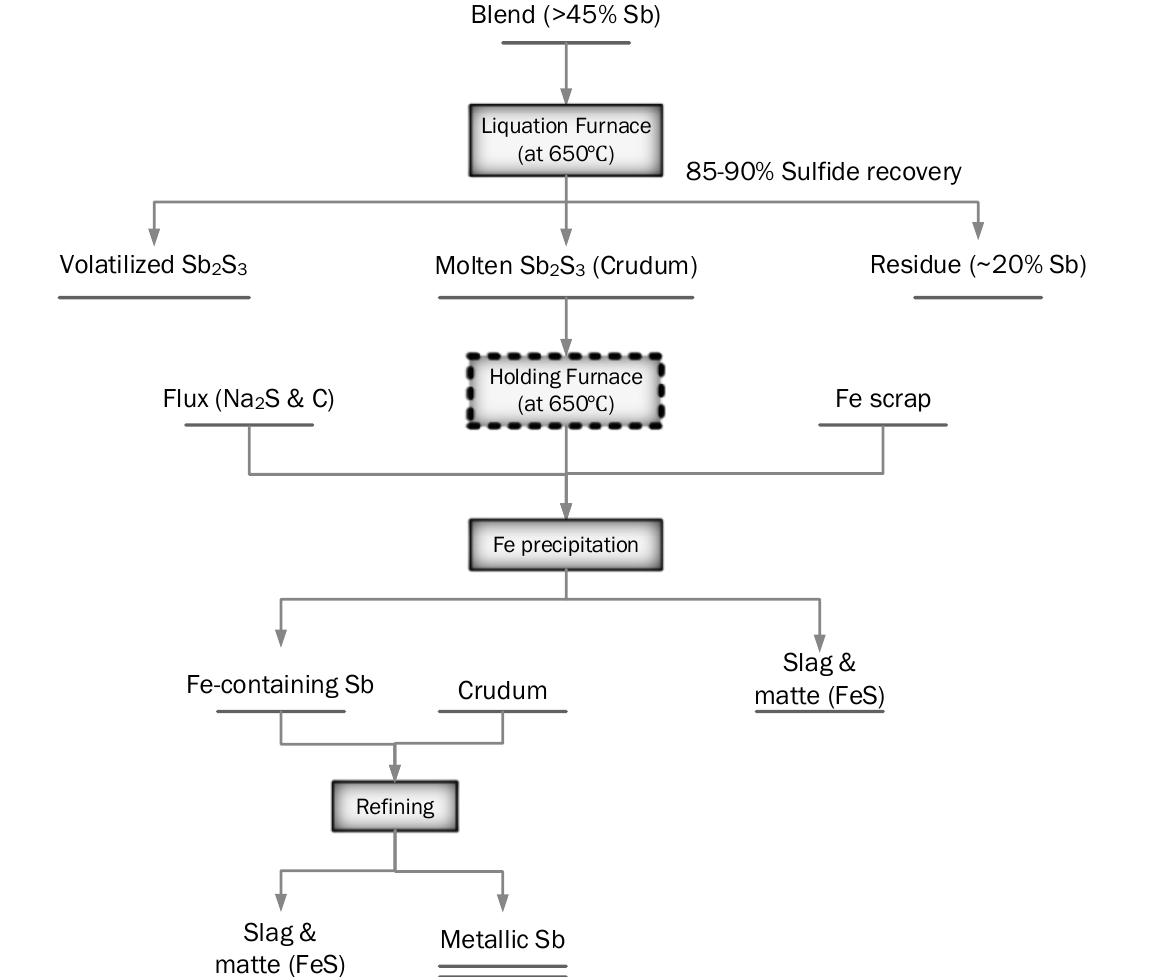
Figure 11. A potential flowsheet for recovery of antimony from high antimony concentrates; liquation followed by iron-precipitation. Holding furnace is optional for the process.